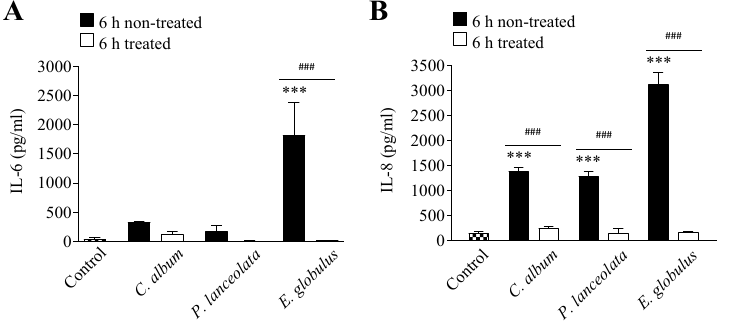
Figure 5. E ff ect of pollen proteases from Chenopodium album (0.26 ± 0.06 mg / mL), Plantago lanceolata (0.18 ± 0.03 mg / mL) and Eucalyptus globulus (0.75 ± 0.18 mg / mL) on IL-6 ( A ) and IL-8 ( B ) release. The